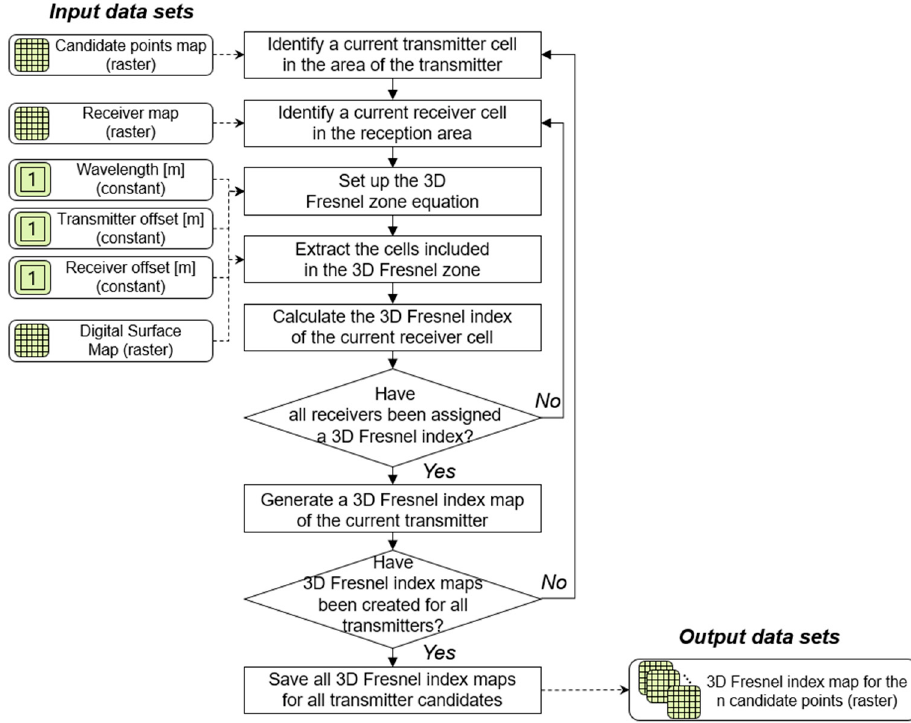
Figure 3. Procedure for generating 3D Fresnel index maps for all transmitter candidates via communication viewshed analysis of topographic data.